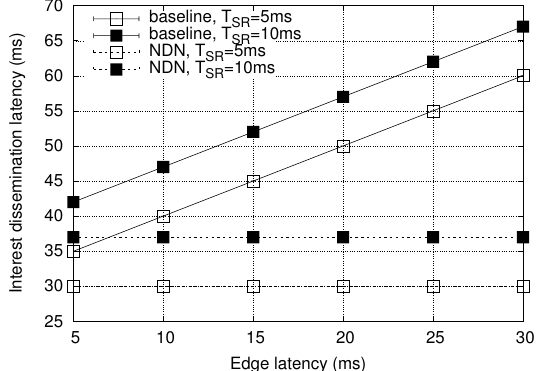
Figure 5. Average Interest dissemination latency when varying the scheduling periodicity ( T SR ): our proposal against a baseline non-NDN